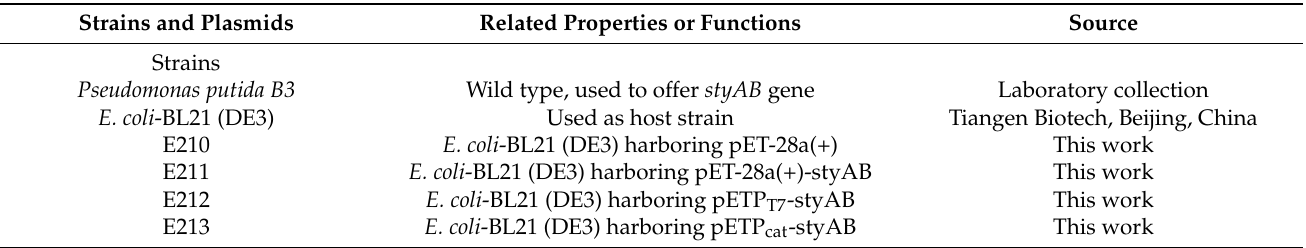
Table 1. Plasmids and strains used in this